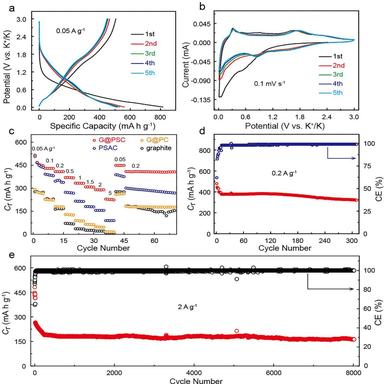
The electrochemical evaluation of G@PSC electrode for KIBs in 0.8 mol L1 KPF6 in EC: DEC (1:1 in volume). (a) GCD curves of the first five cycles at 0.05 A g1 . (b) CV curves of the initial five cycles at 0.1 mV s1 . (c) The rate capabilities of G@PSC, PSAC, G@PC and pure graphite at various current rates. (d) The cycling performance of G@PSC at 200 mA g1 (firstly stabilized at 0.05 and 0.1 A g1 ). (e) The long-term cycling performance of G@PSC at 2 A g1 (firstly stabilized at 0.05 and 0.2 A g1 ).